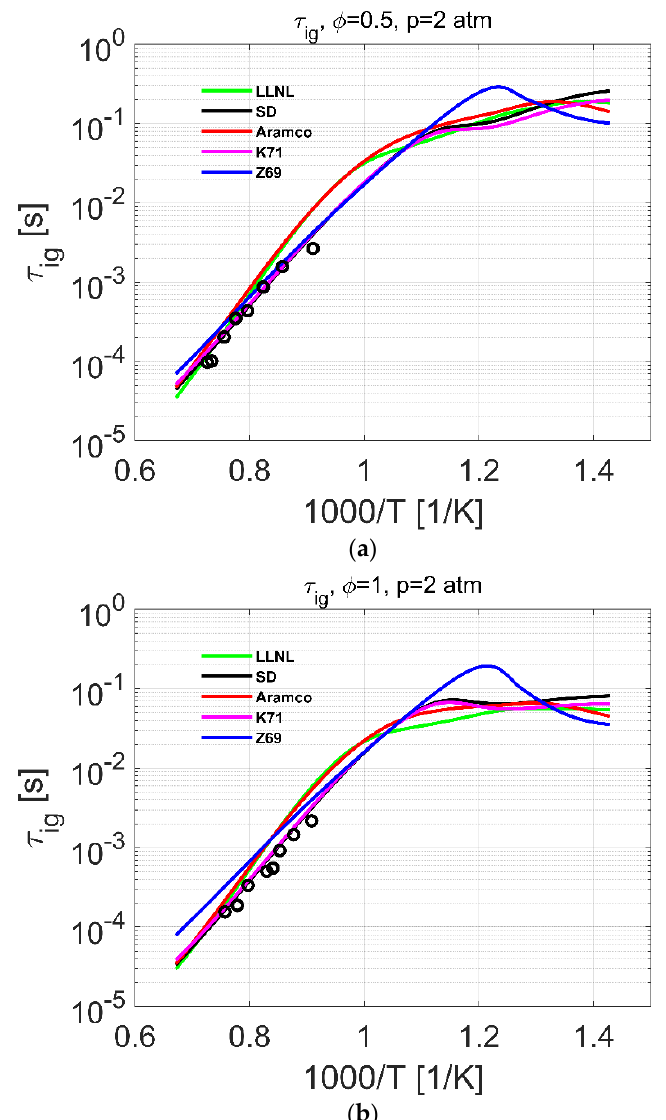
Figure 7. Ignition delay time for DME-air mixtures at 2 atm and ϕ = 0.5 in ( a ) and ϕ = 1.0 in ( b ). Legend: experimental data for τ ig from ( ) Jiang et al. [15]. Mechanism predictions from Z69 in blue, LLNL in green [28], Aramco in red [17], K71 in magenta [32] and San Diego in black [30].